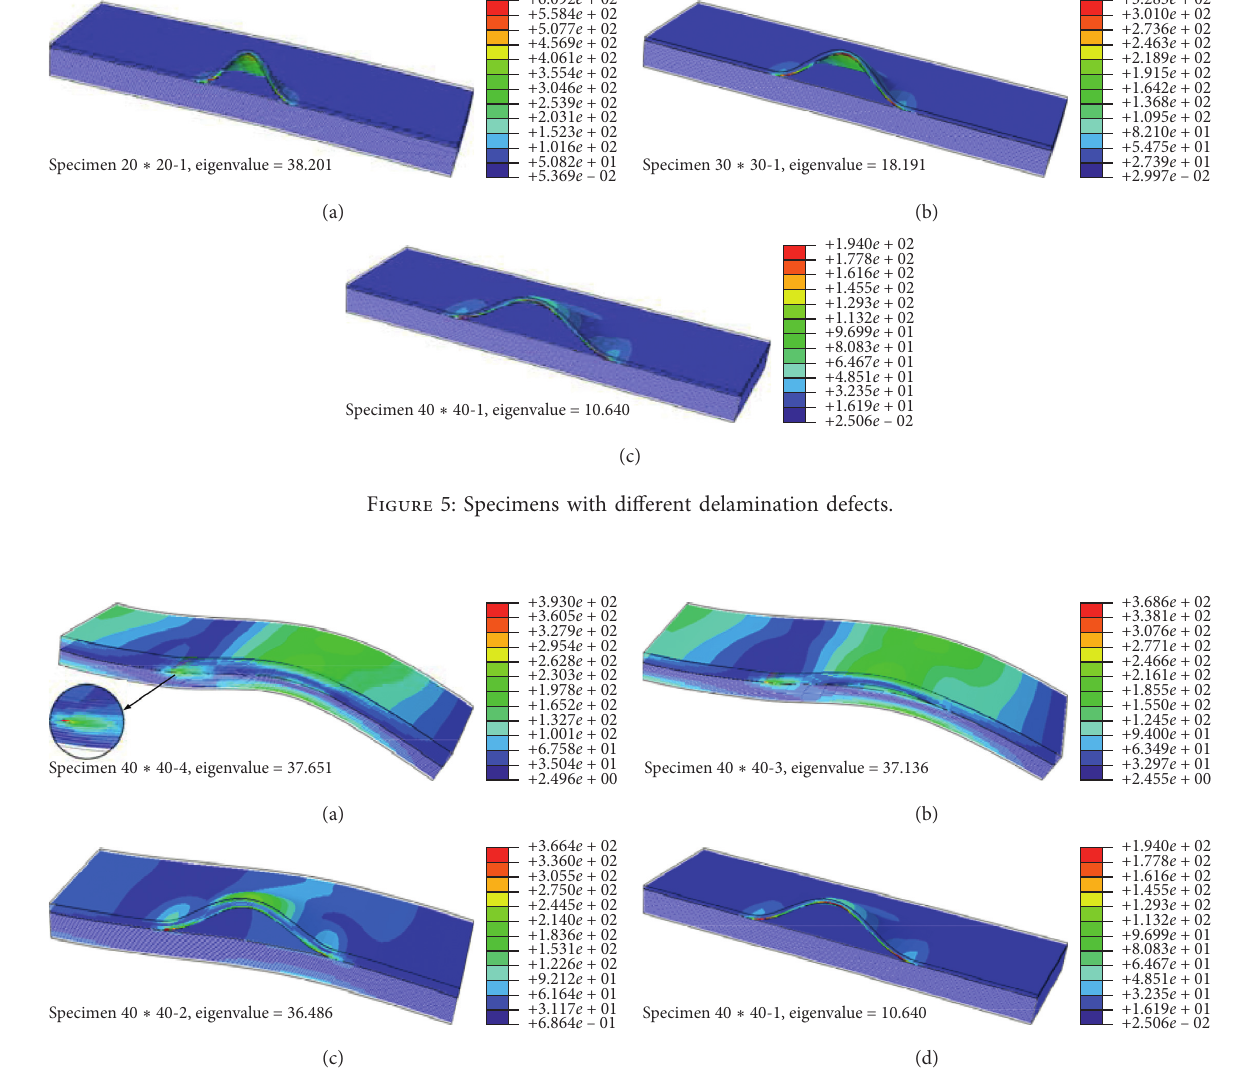
Figure 6: Specimens with different delamination